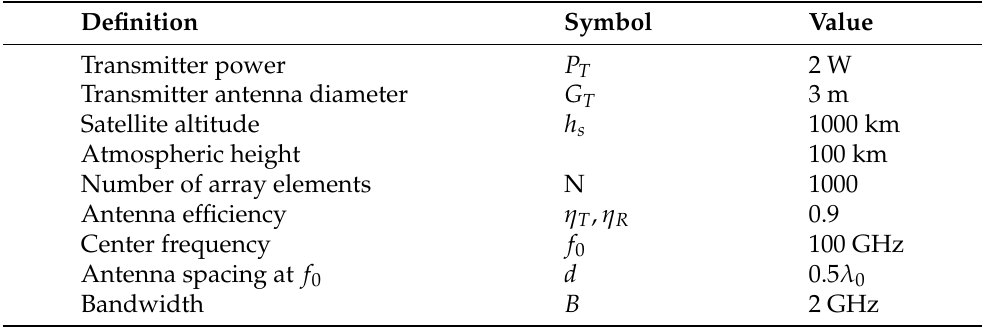
Table 1. Simulation